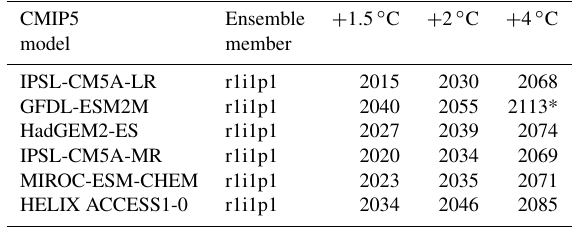
Table 5. List of high-end climate change CMIP5 models that are downscaled using HadGEM3-A. The years when the CMIP5 mod- els pass + 1 . 5, + 2, and + 4 ◦ C global average warming relative to the pre-industrial period are